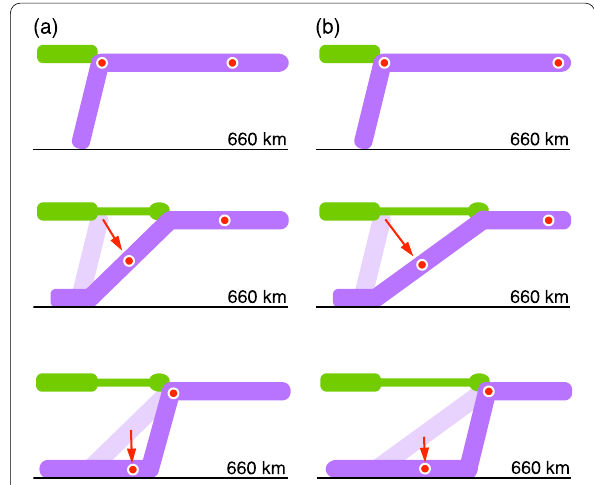
Fig. 7 Cartoons illustrating how one particular segment of the slab subducts during a cycle of back-arc spreading. The distance between the two red circles corresponds to a fixed length, and their locations highlight the movement of the slab. a In the present model, the length is ~ 900 km for the case shown in Fig. 3. b In natural subduction zones, the effect of toroidal mantle flow around the slab edge will enhance trench rollback and the subducted length may be greater than shown in Fig.